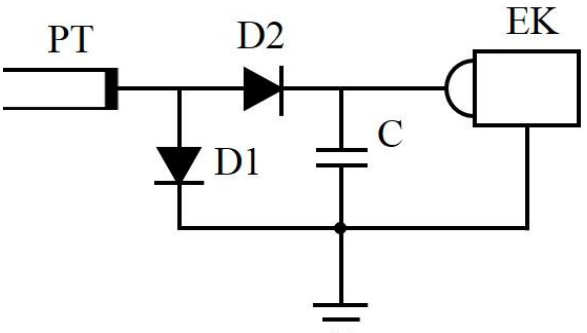
Figure 3. The diagram of the voltage doubler for verification of the value of the high voltage. D1 and D2 are semiconductor 18 kV diodes DD1800, the capacity of the output capacitor C is 100 pF, EK is